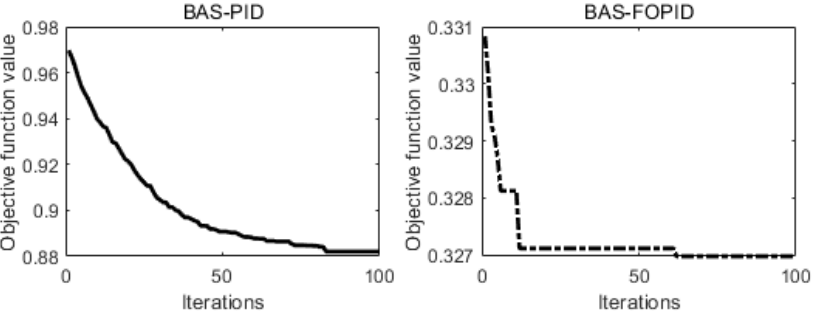
Figure 14. Objective function optimization curve.